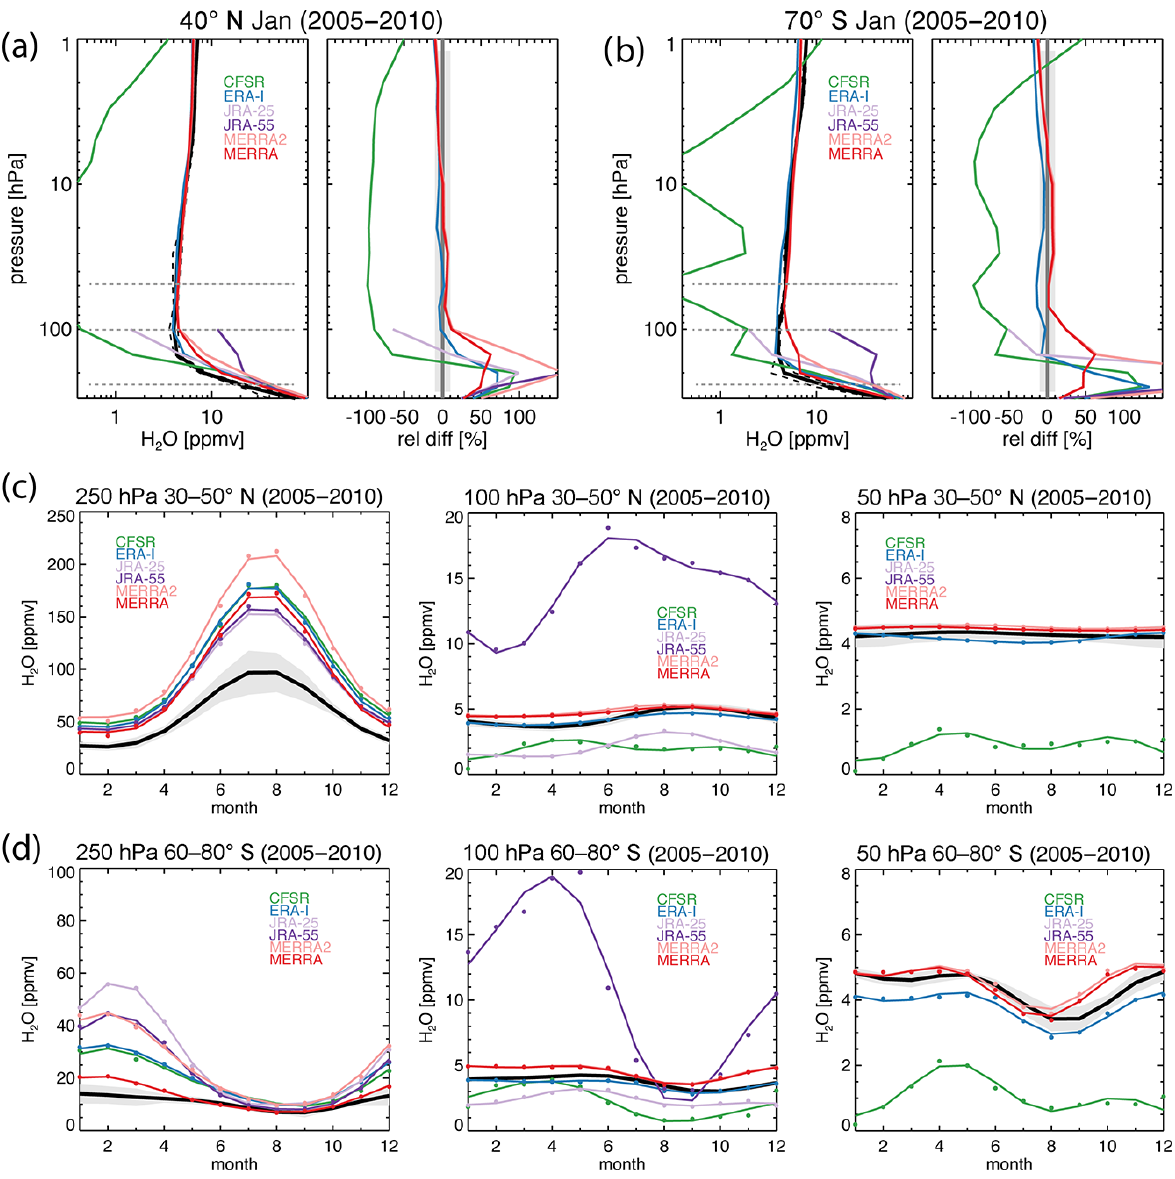
Figure 13. Multi-annual mean vertical water vapor profiles over 2005–2010 for January at (a) 40 ◦ N and (b) 70 ◦ S from the SPARC Data Initiative multi-instrument mean (SDI MIM) (black) and the six reanalyses (colored). Absolute values are shown in the left panels and relative differences in the right panels for each comparison. Relative differences are calculated as (R i − MIM )/ MIM · 100, where R i is a reanalysis profile. Black dashed lines provide the ± 1 σ uncertainty (as calculated by the SD over all instruments and years available) in the observational mean. Horizontal dashed lines in grey indicate the pressure levels (250, 100, and 50hPa) for which seasonal cycles are shown in panels (c, d) for the two latitude ranges 30–50 ◦ N and 60–80 ◦ S,